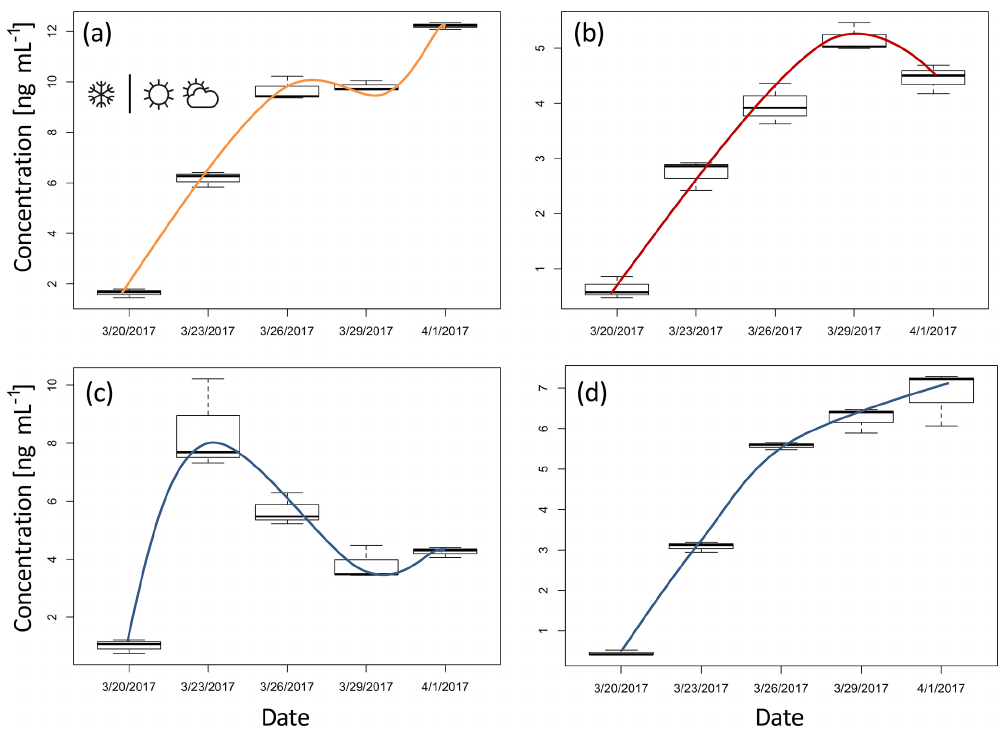
Figure 3. Box plots of concentration for ions representing four distinctive groups (tick line of a box represents the median and upper and lower line maximum and minimum values): (a) ion m/z 115.070 – pinonic acid, (b) ion m/z 85.029 – levoglucosan, (c) ion m/z 99.008, and (d) ion m/z 159.065. The lines illustrate the change in the concentration over the time that is typical for each group. The first sample is taken just after the precipitation (snow symbol), followed by a non-precipitation period for the rest of the experiment (other weather